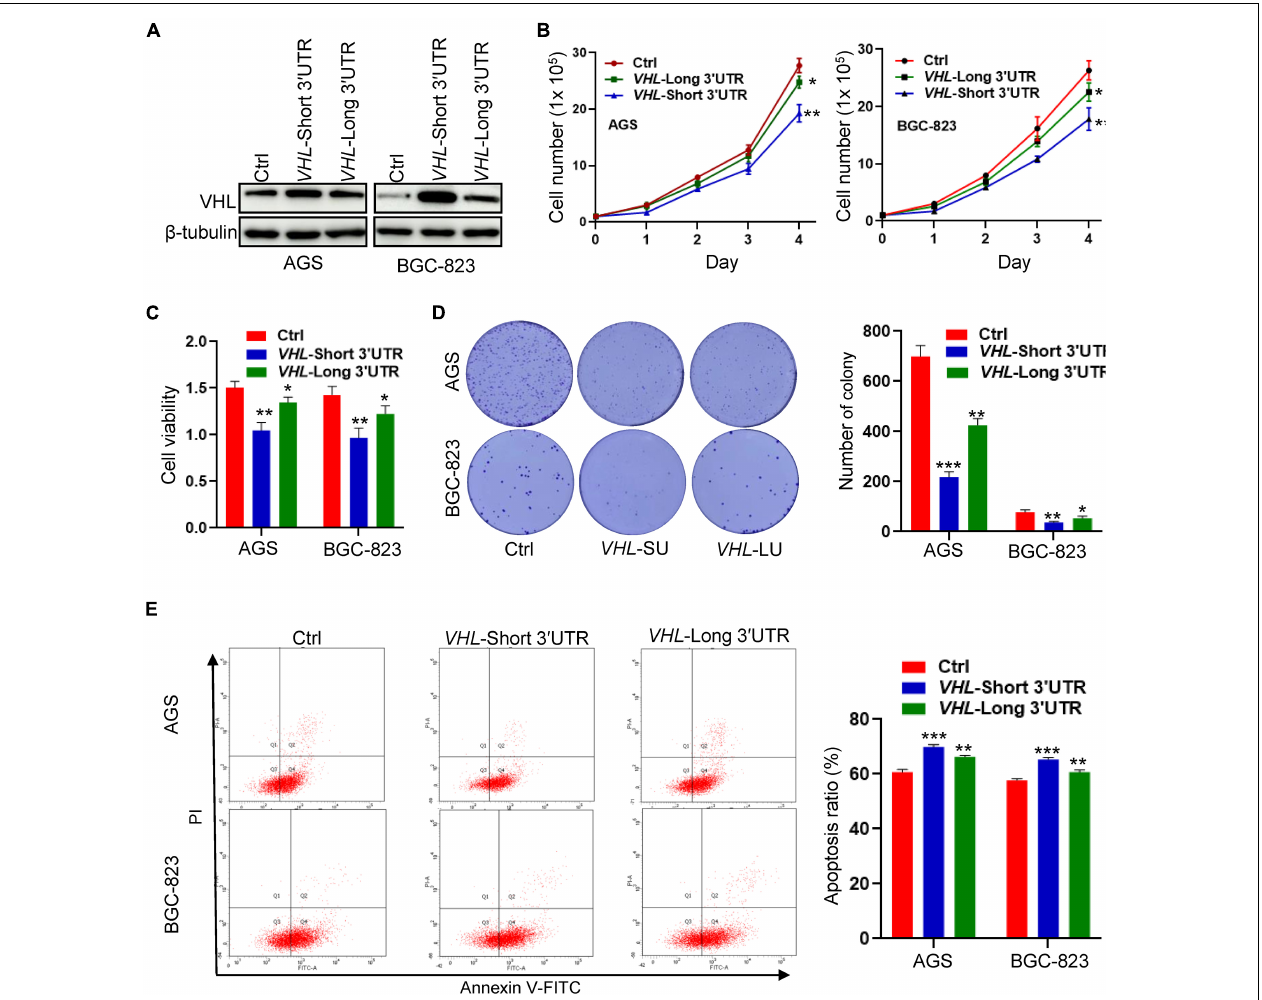
FIGURE 6 | The VHL isoform with short 3 (cid:48) UTR inhibits cell growth and promotes apoptosis in GC cells. (A) Western blotting analysis of VHL expression in AGS and BGC-823 cells stably transfected with distinct VHL isoform with short or long 3 (cid:48) UTR. (B,C) Detection of cell proliferation and viability after stably enforced expression of the short- or long-3 (cid:48) UTR isoform of VHL in AGS and BGC-823 cells. (D) Detection of colony formation after stably enforced expression of the VHL isoform with short or long 3 (cid:48) UTR in AGS and BGC-823 cells. (E) Apoptosis ratio was analyzed in AGS and BGC-823 cells. *0.01 < p < 0.05; **0.001 < p < 0.01; *** p <